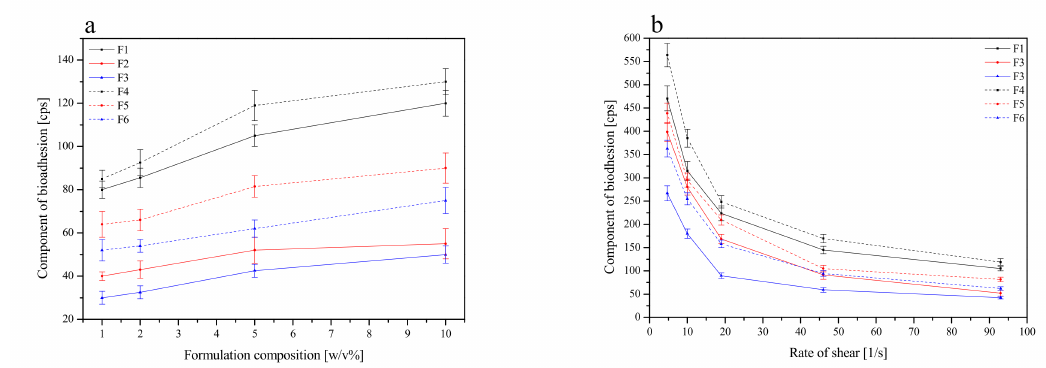
Figure 7. Effect of polymer concentration (1–10%) on the component of bioadhesion for formulations F1–F6 at rate of shear 93 1/s ( a ), and effect of the rate of shear on the component of bioadhesion for 5% of formulations F1–F6 ( b ).